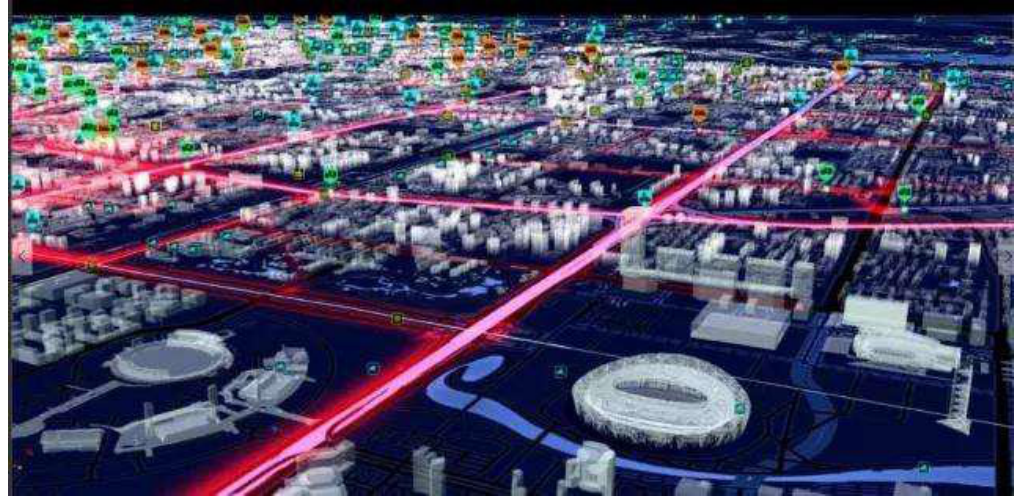
Fig.9 urban grid hospital